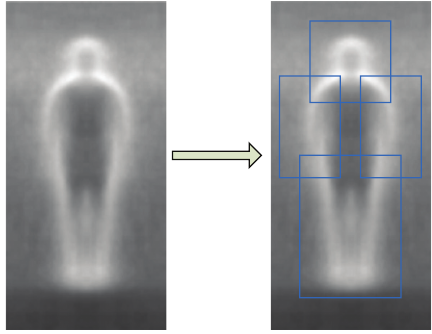
Figure 6: ROI of average